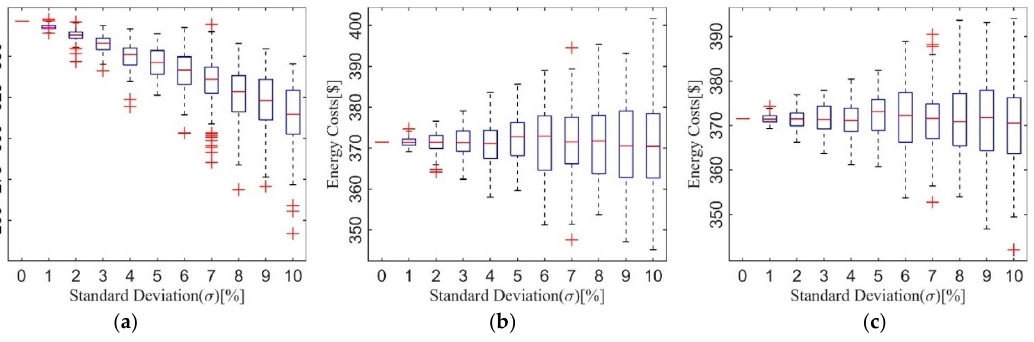
Figure 6. Distribution of Network Losses: ( a ) Price-guided Case; ( b ) Loss-guided Case; ( c ) Random Case.